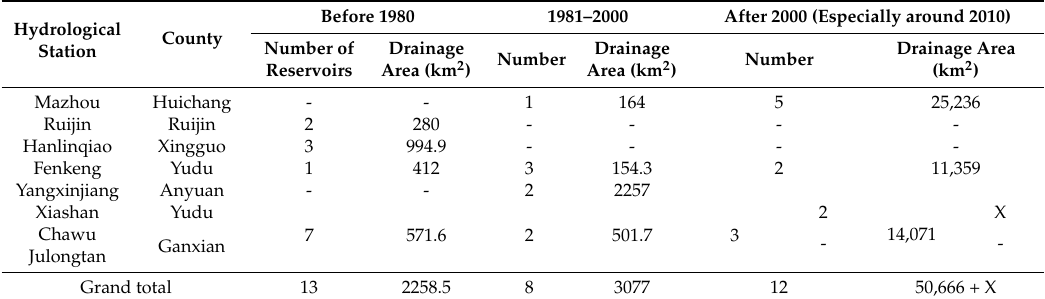
Table 8. The construction of large- and medium-sized reservoirs in the past 60